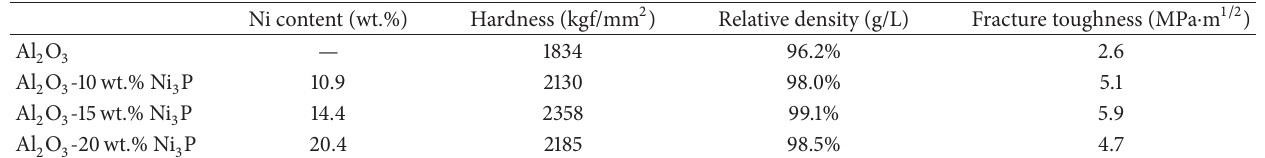
Table 1: Ni contents and material properties of Al 2 O 3 and hot-pressed Al 2 O 3 -Ni-P composites.